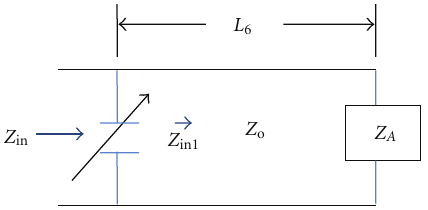
Figure 1: Model of the antenna system including CPW feed line and shunt varactor.